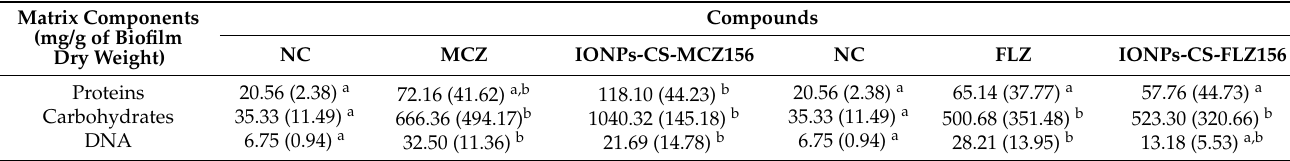
Note: for each component of the extracellular matrix, different lowercase letters represent significant differences among the groups (one-way ANOVA and Fisher LSD’s test; p < 0.05). Statistical comparisons were performed separately for each antifungal, its respective nanocarrier, and the negative control (NC). Chitosan (CS)-coated iron oxide nanoparticles (IONPs) carrying MCZ (IONPs-CS-MCZ156) or FLZ (IONPs-CS-FLZ156), both at 156 µ